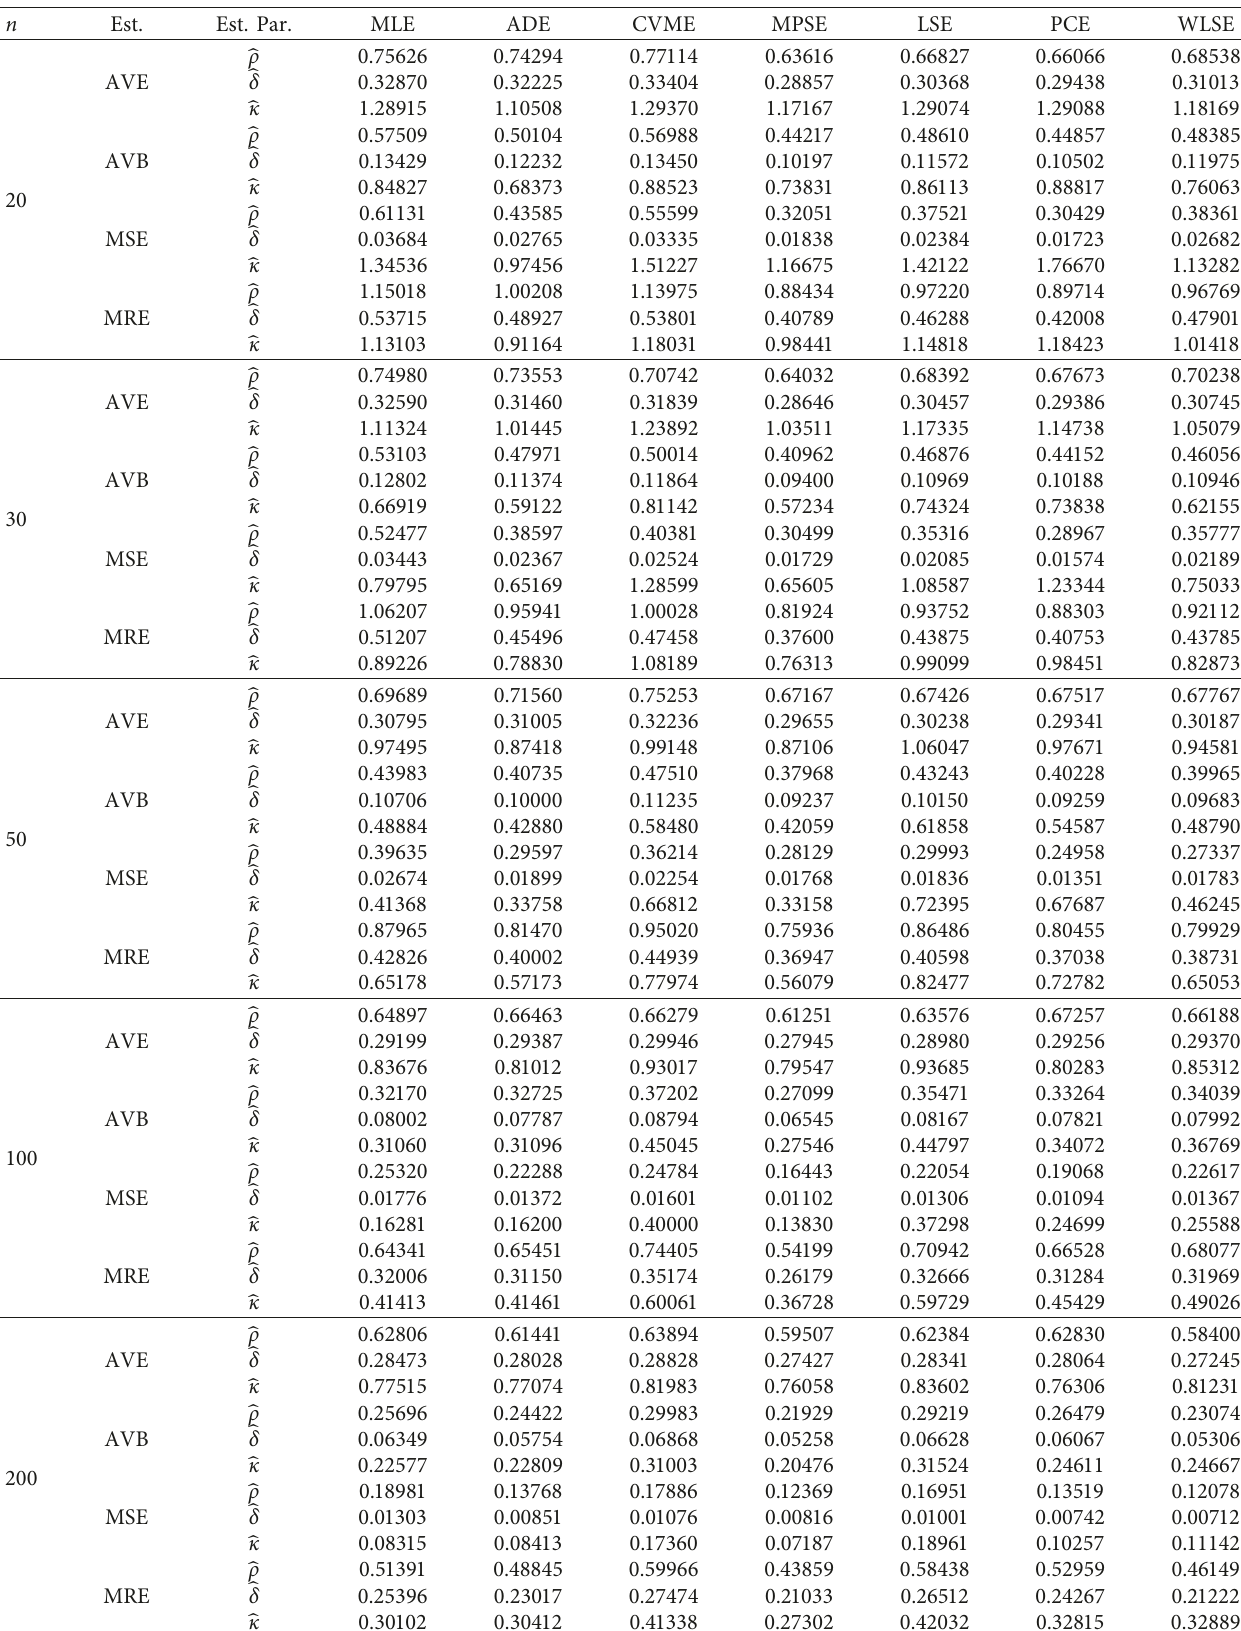
Table 1: Simulation results of the AVE, AVB, MSE, and MRE of BXLE distribution for ( ρ � 0 . 5 , δ � 0 . 25 , κ � 0 . 75 ) . n